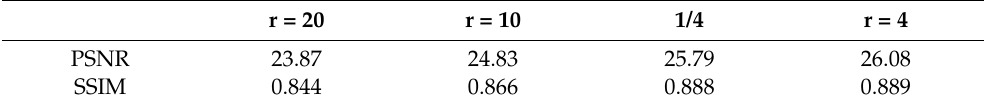
Table 4. Studies of reselecting data on small-scale training set. The model was trained on Rain800 [21] and tested on Test100 [21]. r represents the proportion of reselected data to the total and 1/4 means fixed quarter of total data.